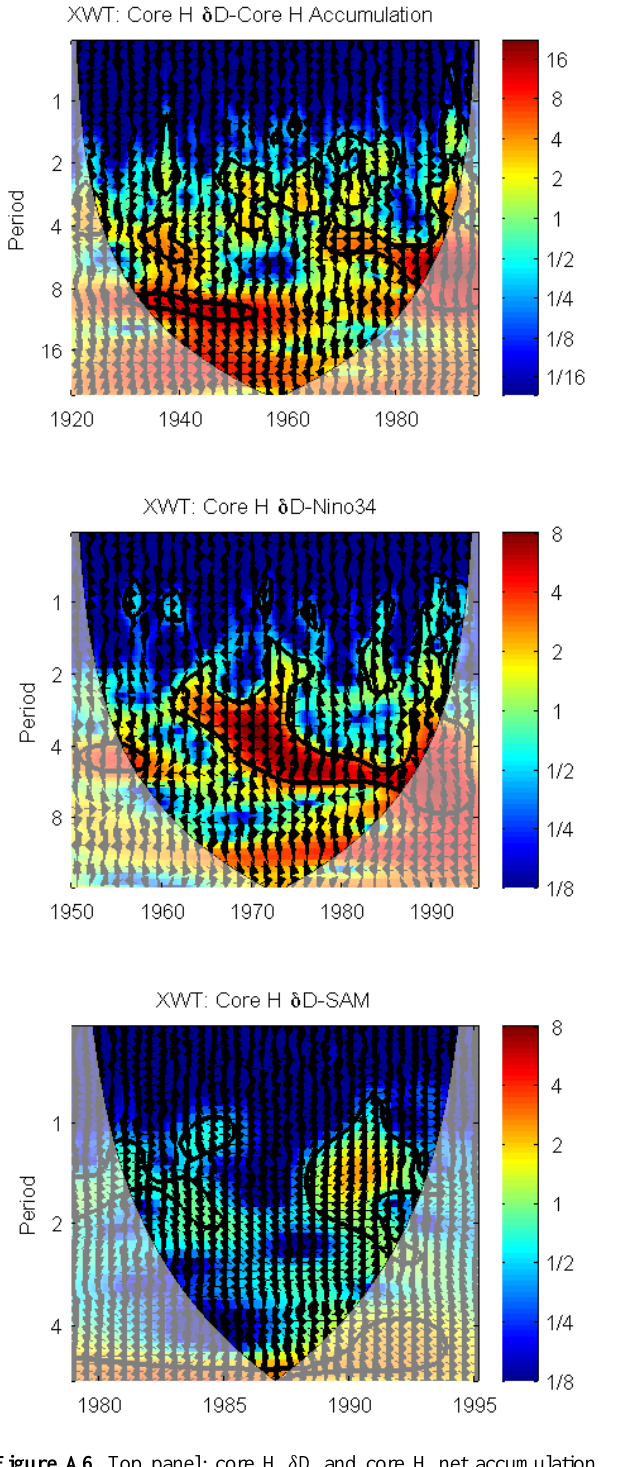
H δ D and Core H Net Accumulation XWT from 1657-1995. Middle) Core H δ D and Ni˜no 3.4 XWT from 1950-1995. Figure A.6. Top) Core Bottom) Core H δ D and SAM XWT from 1979-1995. www.jn.net